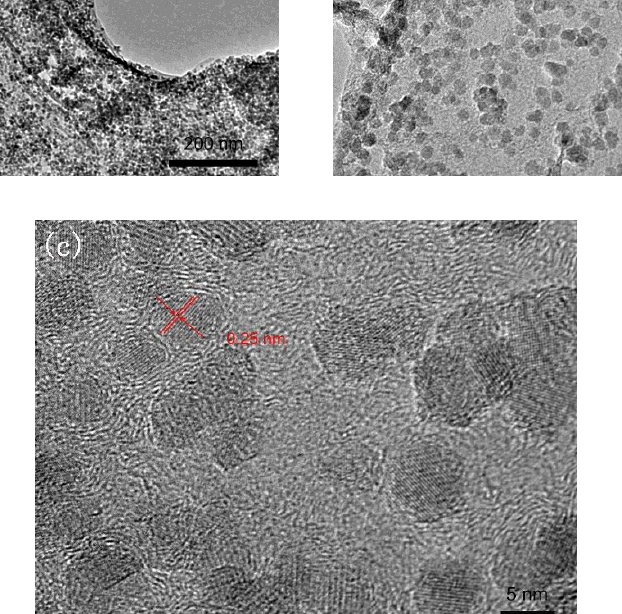
Figure 2. ( a , b ) TEM and ( c ) HRTEM images of RGO/Fe 3 O 4 nanocomposite.